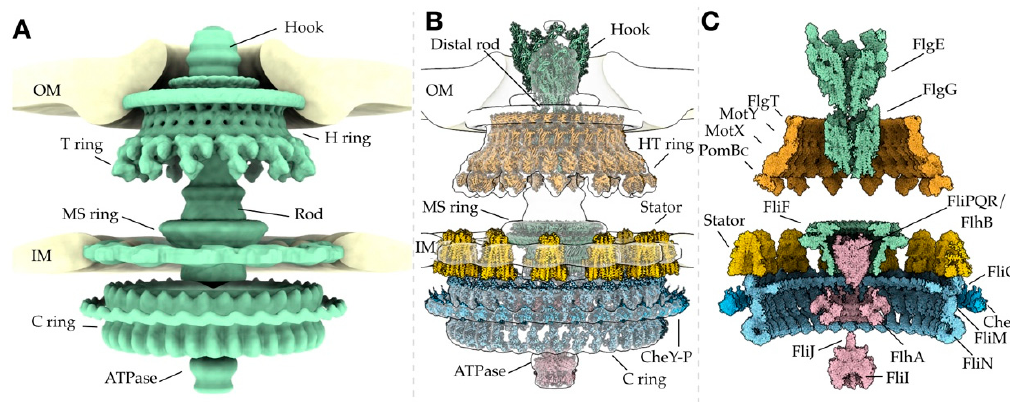
Figure 3. High-resolution cryo-EM and X-ray models placed in cryo-ET maps provide a basis for understanding flagellar assembly and function. ( A ). An assembled cryo-ET map of z motor trapped in the CW rotation (EMDB 3155, 21837, and [143]), depicting the general shape of the molecular components that assemble into the intact motor. ( B ). High-resolution cryo-EM and X-ray structures of the flagellar components are placed in the cryo-ET map (white). The motor is sliced in half to show the inner and outer structures. ( C ). Available high-resolution structures are shown in full. The models used for this reconstruction are: FlgE (PDB 6KFK), FlgG (PDB 6JZR), FlgT (PDB 3W1E), MotY (PDB 2ZF8), MotX (theoretical [181]), PomB C (PDB 3WPW), FliF (PDB 6SD5), FliPQR–FlhB (PDB 6S3L), FliG (PDB 3HJL and 4FHR), CheY (PDB 1F4V), FliM (PDB 4FHR and 4YXB), FliN (PDB 4YXB and 1YAB), FlhA (PDB 6CH1), FliI (PDB 2DPY), FliJ (PDB 3AJW), and stator (PDB